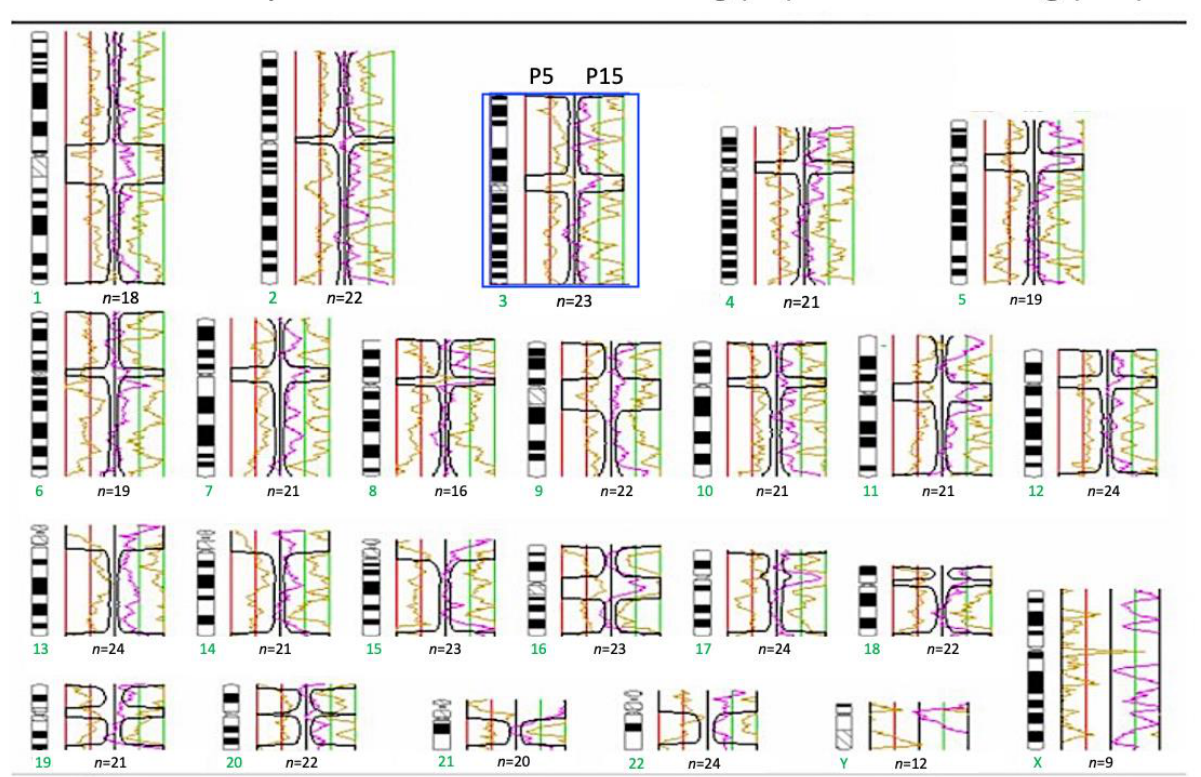
Figure 6. Array comparative genomic hybridization (array-CGH). There was no significant chromosomal change by GCH array in a confidential interval of 99.5% between the 5th (P5) and 15th (P15) passages. The green number meant the chromosome number, X meant X chromosome and Y meant Y chromosome. The blue box showed an example that orange side was the CGH for P5 and the green side was the CGH for P15. The black wave lines showed that the chromosomes were very similar.